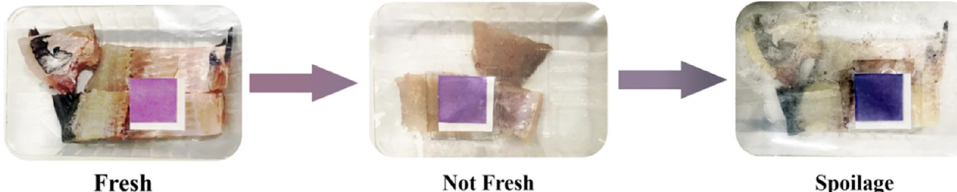
Figure 11. Color change of printable colorimetric paper sensor during monitoring of the freshness of the grass carp within 24 h at 25 °C by Sun et al., Reprinted with permission from ref. [165]. Copyright 2021 Springer Nature.